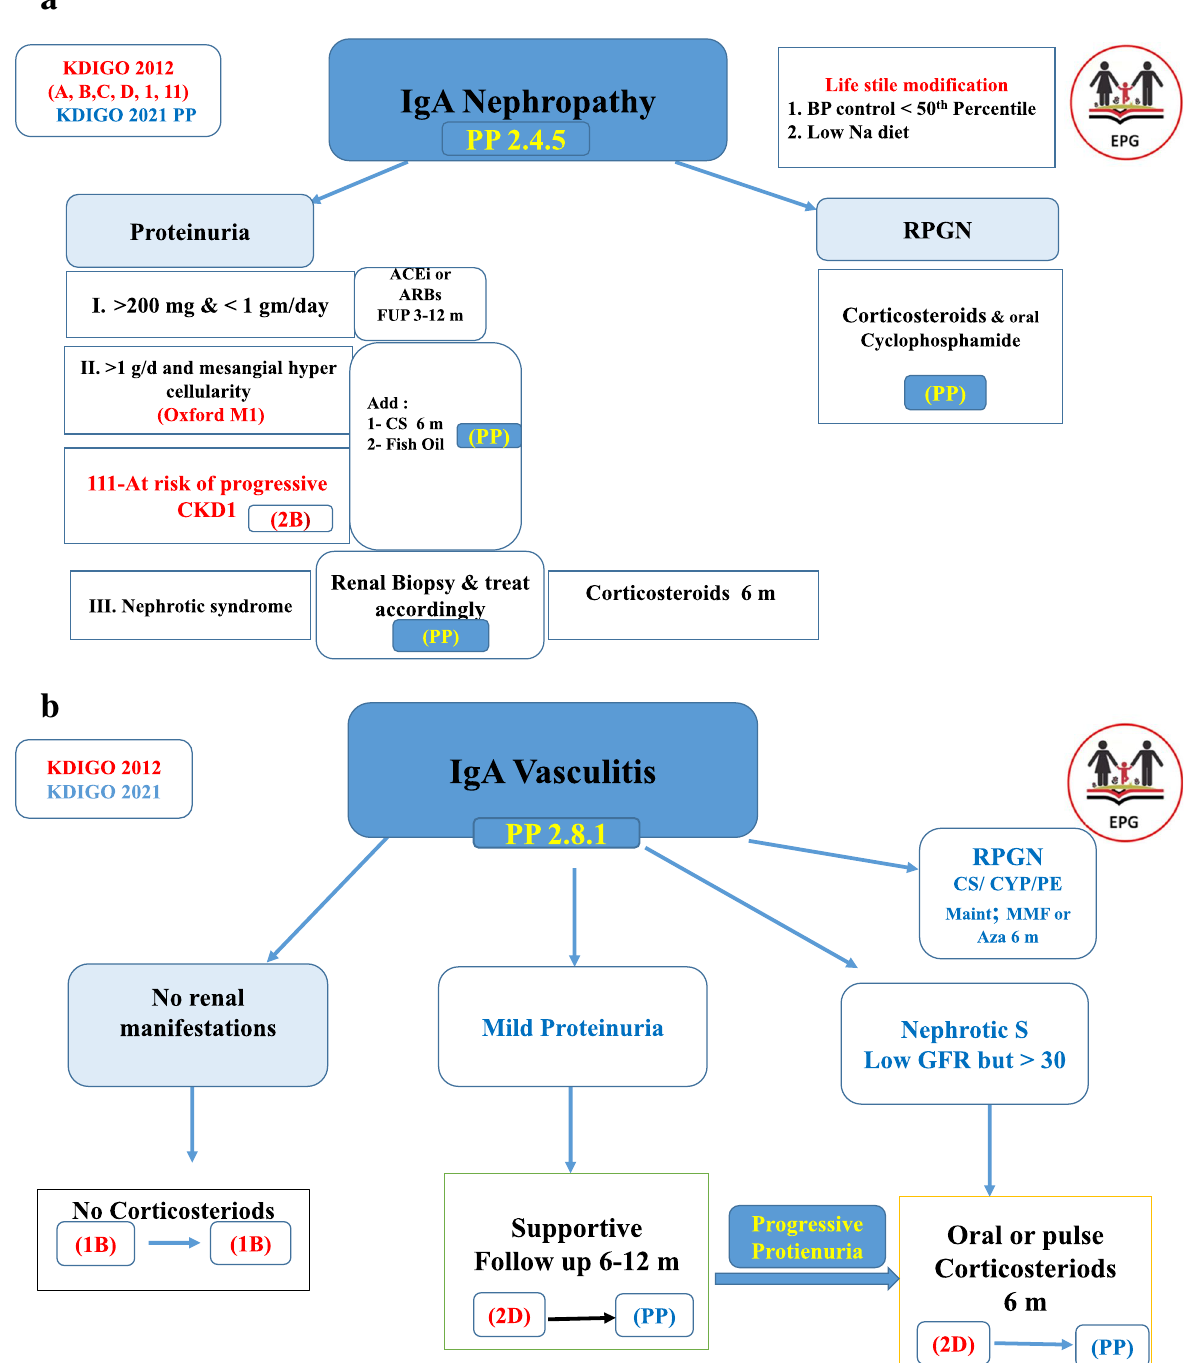
Fig. 5 a EPG management of IgA nephropathy. R 3.2.2 E. b EPG management of IgA vasculitis. R 3.2.2